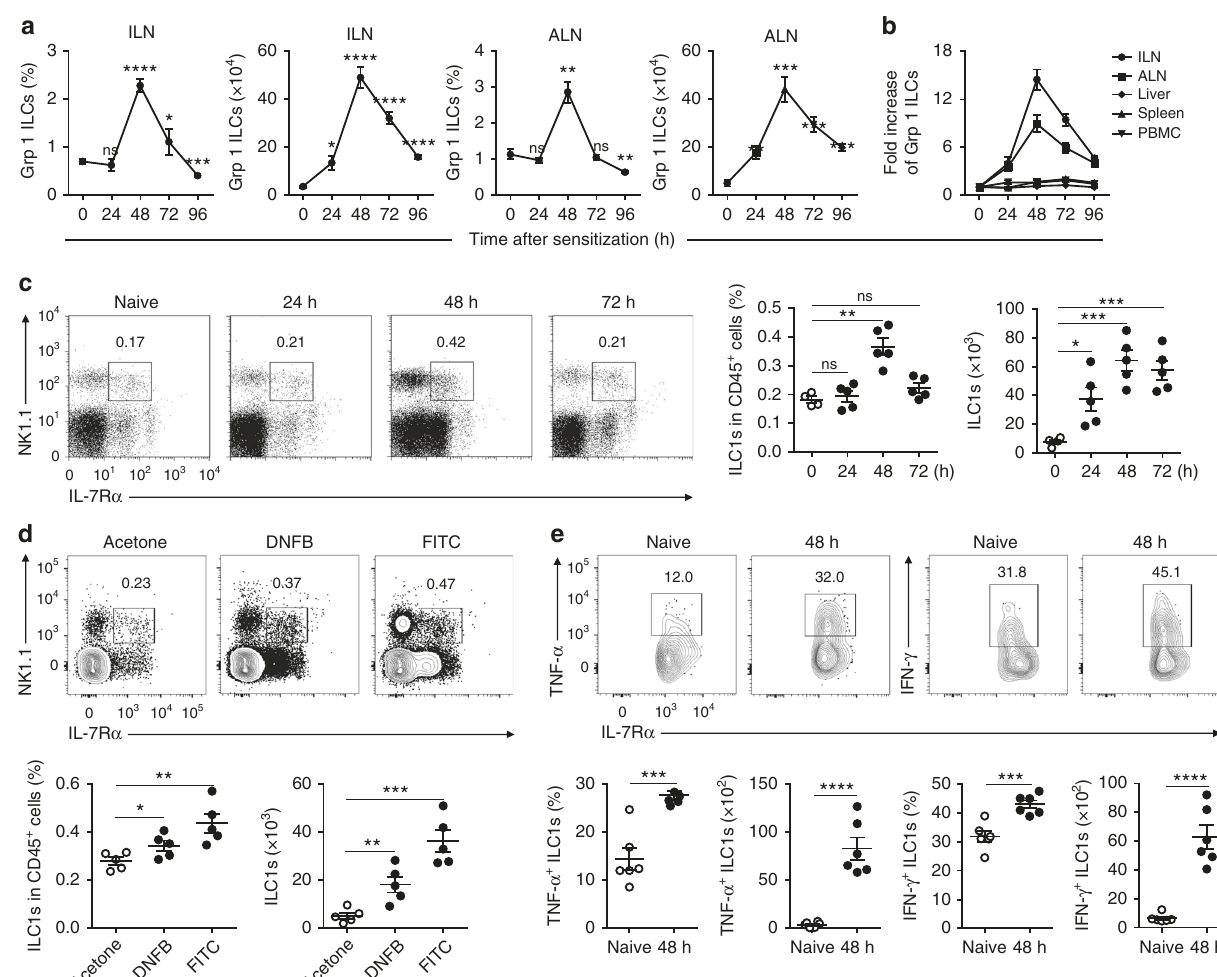
Fig. 2 Haptens induce the accumulation and activation of IL-7R α + ILC1s in skin-draining LNs. a , b Percentages, absolute numbers, and fold increase in numbers of group 1 ILCs (CD3 − NK1.1 + NKp46 + ) from the indicated tissues of WT B6 mice after OXA sensitization. Data are pooled from four independent experiments ( n = 4 – 6 in each group). c Representative dot plots (left panels) showing NK1.1 and IL-7R α expression on ILN CD3 − cells from OXA-sensitized WT B6 mice. Numbers in dot plots represent the percentages of ILN IL-7R α + ILC1s cells among CD45 + cells. Statistical analysis of results (right panels) showing the percentages and absolute numbers of ILN IL-7R α + ILC1s. Data are representative of at least three independent experiments ( n = 4 – 5 in each experiment). d Representative density plots (top panels) showing NK1.1 and IL-7R α expression on ILN CD3 − cells from FITC- or DNFB-sensitized (48 h) WT B6 mice. Numbers in dot plots represent the percentages of ILN IL-7R α + ILC1s cells among CD45 + cells. Statistical analysis of results (bottom panels) showing the percentages and absolute numbers of ILN IL-7R α + ILC1s. Data are representative of two independent experiments ( n = 5 in each experiment). e Representative density plots (top panels) showing expression of TNF and IFN- γ by ILN ILC1s (CD3 − NK1.1 + NKp46 + IL-7R α + ) from naive or OXA- sensitized mice after stimulation of ILN cells with PMA/Ion (for TNF detection) or IL-12/IL-18 (for IFN- γ detection). Statistical analysis of results (bottom panels) showing the percentages and absolute numbers of TNF-producing or IFN- γ -producing ILN ILC1s. Data are representative of two independent experiments ( n = 4 – 5 in each experiment). Means ± SEM are shown. * P < 0.05, ** P < 0.01, *** P < 0.001, **** P < 0.0001, two-tailed unpaired Student ’ s t